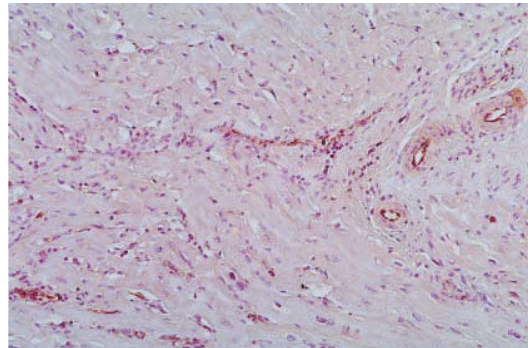
Factor VIII immunostaining of a sample of the control group (image width = 0.8 mm).